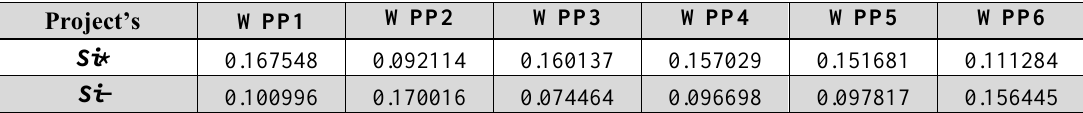
Table 12. Euclidean distance from ideal best Si+ and from ideal worst Si-